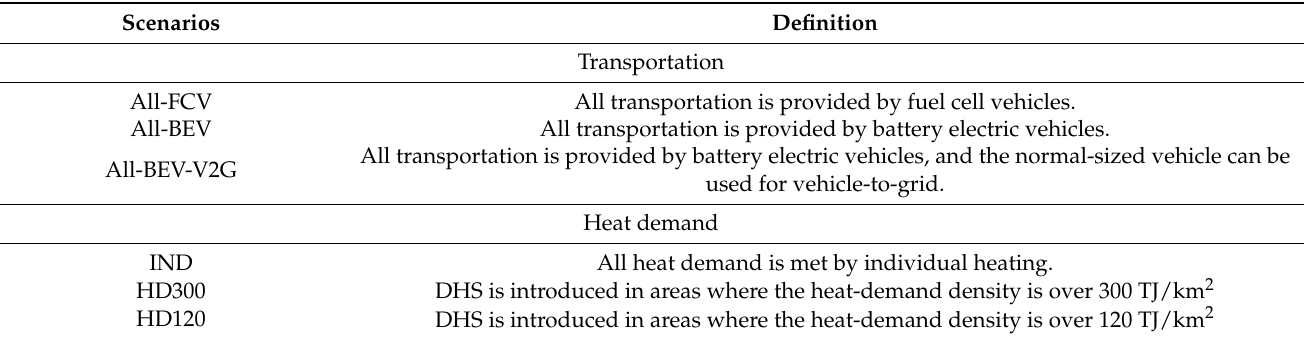
Table 3. Description of scenarios analyzed in this